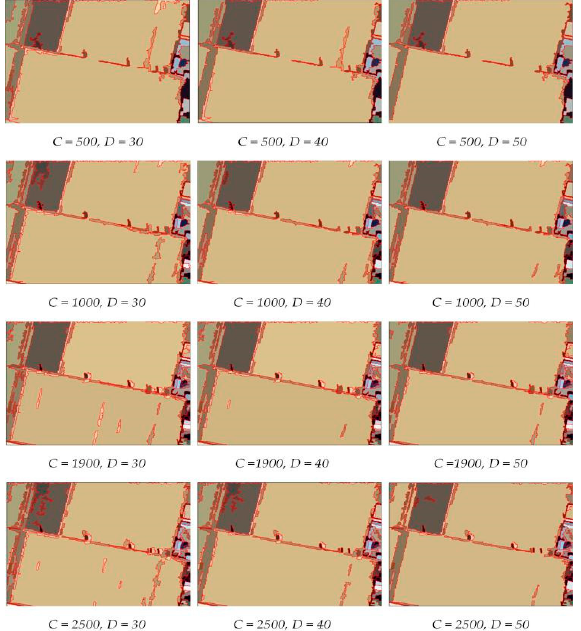
Figure 7. Some important segmentation results of cultivated land boundaries using the Lab-RMWS.